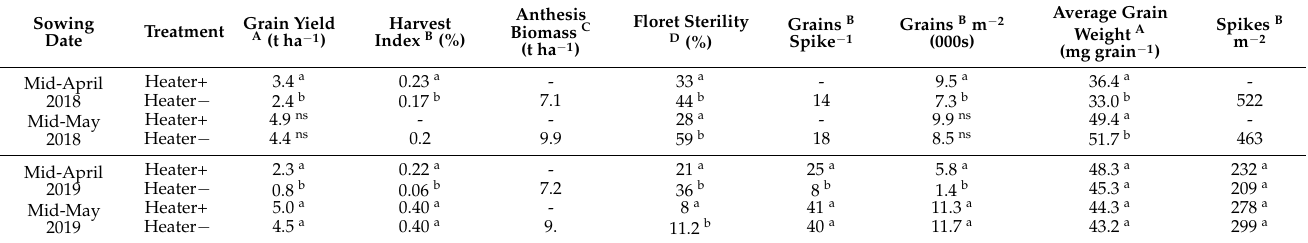
Table 1. Values are predicted means ( n = 3) of grain yield, floret sterility and yield components of wheat ( cv. Wyalkatchem) in heated and non-heated plots for the 2018 and 2019 seasons at Dale, Western Australia. Lowercase superscript letters indicate significant mean differences tested using a Fisher’s protected LSD test ( p < 0.05) for comparisons within each sowing date (ns = not significant). Data are taken from harvest grain samples A and the whole harvest index cut B , anthesis biomass cut C (Z65) and floret sterility D from main stem spikes collected at